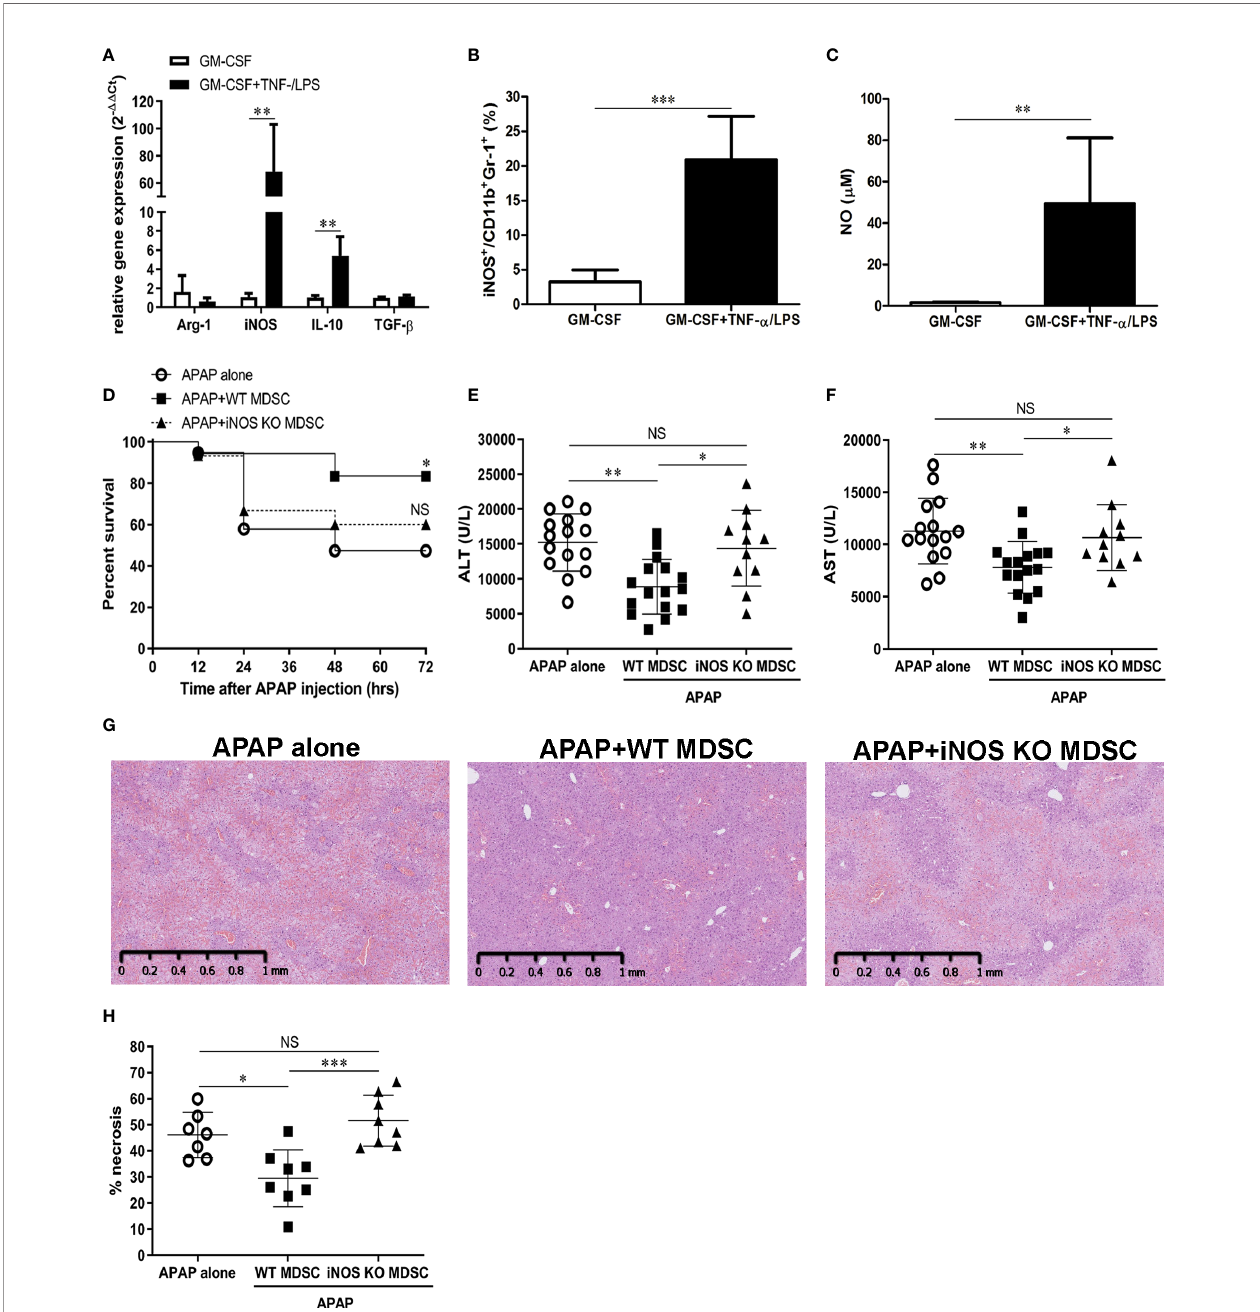
FIGURE 6 | TNF- a /lipopolysaccharide (LPS) myeloid-derived suppressor cells (MDSCs) ameliorate acetaminophen (APAP)-induced liver injury through iNOS (A) mRNA expression of in vitro -generated MDSCs cultured with GM-CSF alone or combined with TNF- a /LPS. (n=6),**P < 0.01, Mann-Whitney test. (B) iNOS expression in MDSCs was measured by fl ow cytometry(n=8), ***P < 0.001, Mann-Whitney test. (C) NO production in the culture media of MDSCs (n=6), **P < 0.01, Mann-Whitney test. (D) BALB/c mice were adoptively transferred with WT or iNOS KO TNF- a /LPS MDSCs just after APAP challenge. The survival of mice was plotted (n=17-20). *P < 0.05, NS, no signi fi cance, Log-rank test. (E) The serum ALT at 12 h after APAP challenge (n=11-16). (F) The serum AST at 12 h after APAP challenge (n=11-16).*P < 0.05, **P < 0.01, NS, no signi fi cance. Kruskal-Wallis test. Data were expressed as mean ± SD. (G) Representitive of liver histological stain of mice with indicative treatment. (H) The quati fi cation of liver necrosis (n=7-8). *P < 0.05, ***P < 0.001, NS, no signi fi cance. Kruskal-Wallis test. Data were expressed as mean ±